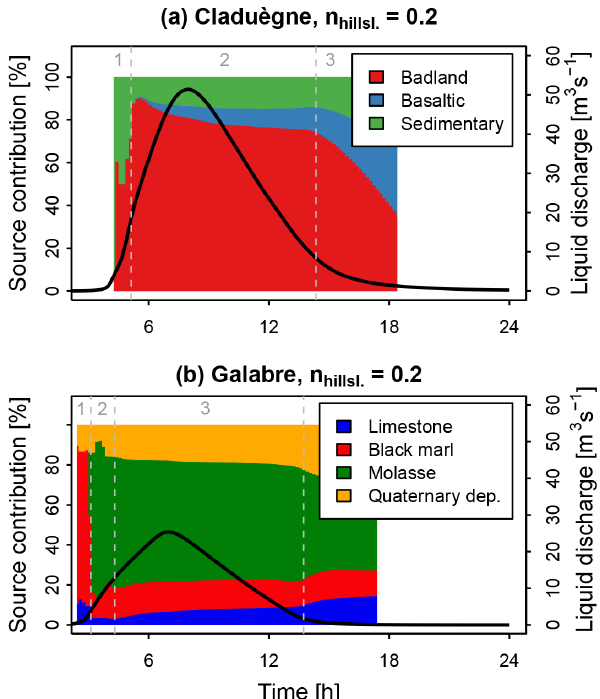
Figure 9. Modeled contributions of the sediment sources in the two catchments when Manning’s n on the hillslopes was set to 0.2 (Sc. 3a). The color shows the contribution of the different sources to total suspended sediment load in percent. The hydrograph is ad- ditionally shown to represent the timing of the event. The results obtained with all roughness values for both catchments can be visu- alized in interactive figures at https://shiny.osug.fr/app/EROSION_ MODEL.2020 (last access: 2 March